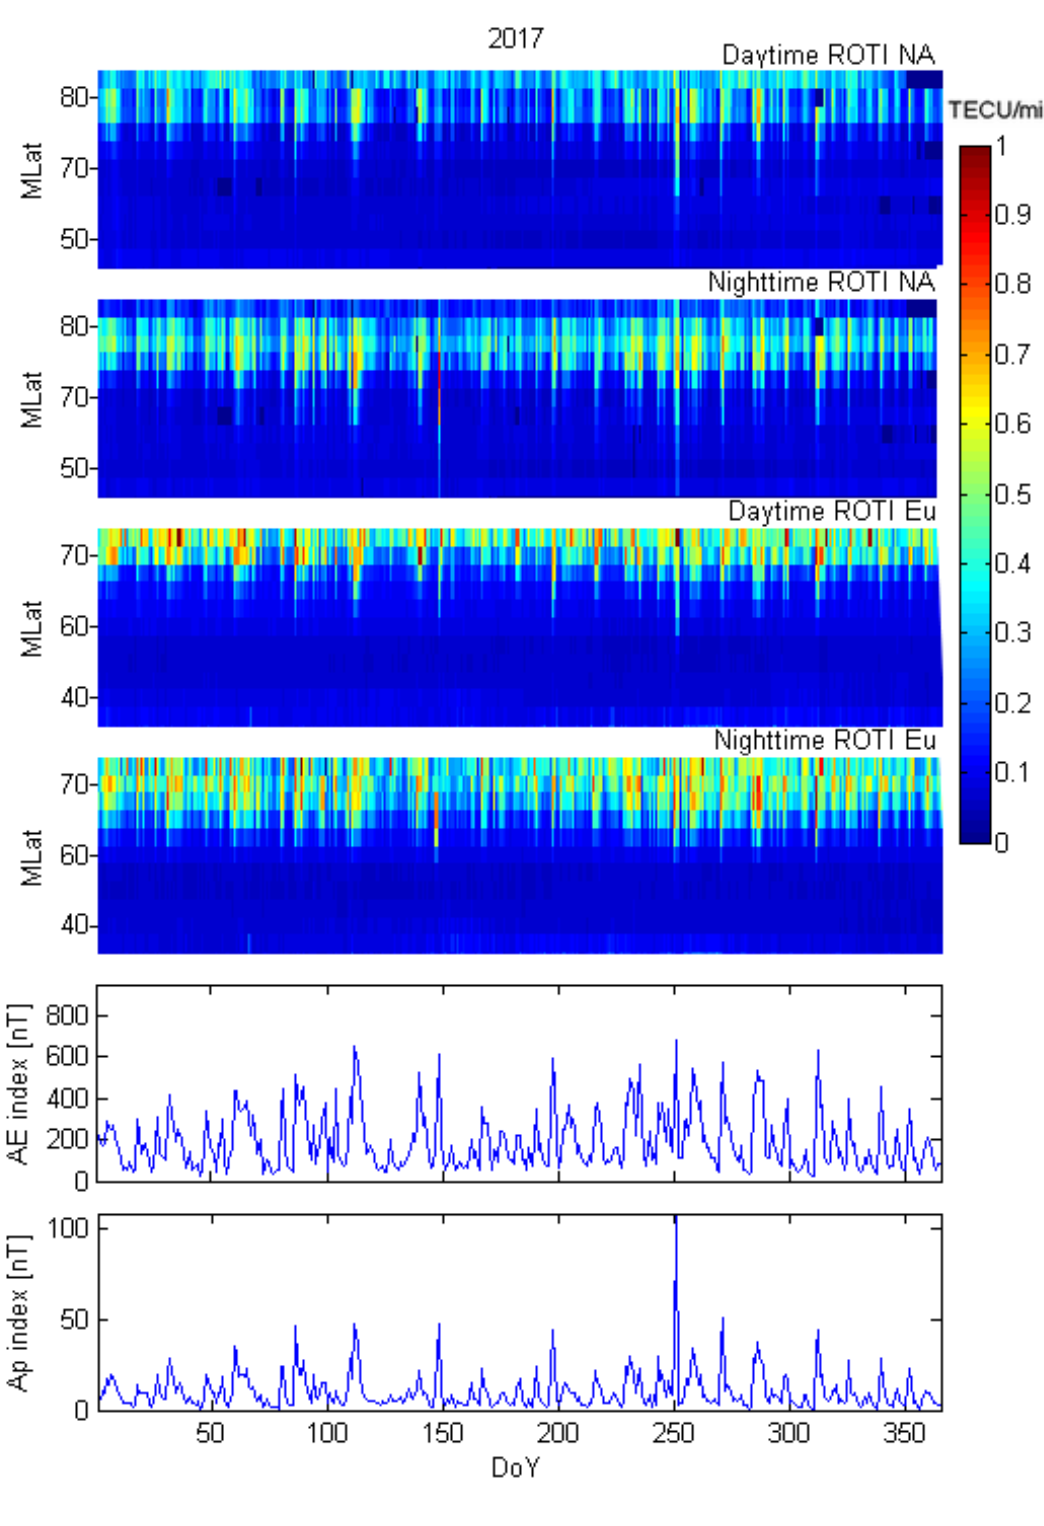
Figure 7. The same as Figure 5 but for the year